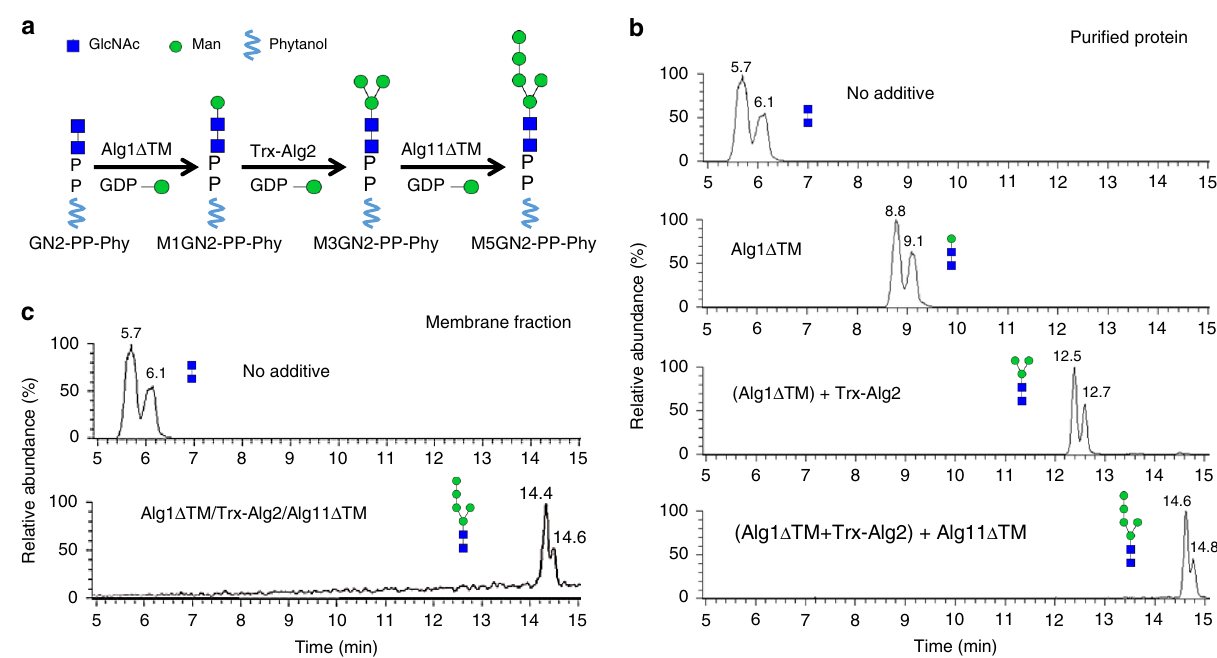
Fig. 2 In vitro M5GN2-PP-Phy synthesis. a Schematic diagram of sequential mannosylation reactions catalyzed by Alg1 Δ TM, Trx-Alg2, and Alg11 Δ TM. b UPLC chromatograms of hydrolyzed glycans from reactions with various combinations of puri fi ed MTases. Each segment of sequential reactions was incubated for 12 h, as described in Methods. Reactions that included GN2-PP-Phy, GDP-Man, and Alg1 Δ TM produced M1GN2 (Alg1 Δ TM); sequential addition of Alg1 Δ TM and Trx-Alg2 produced M3GN2 [(Alg1 Δ TM) + Trx-Alg2]; sequential addition of Alg1 Δ TM, Trx-Alg2, and Alg11 Δ TM generated M5GN2 [(Alg1 Δ TM + Trx-Alg2) + Alg11 Δ TM]. c UPLC chromatogram of hydrolyzed glycans from a one-pot reaction containing GN2-PP-Phy, GDP-Man, and a membrane fraction puri fi ed from E. coli that co-expressed Alg1 Δ TM, Trx-Alg2, and Alg11 Δ and Alg11 Δ TM, to produce M5GN2-PP-Phy (Fig. 2a). The